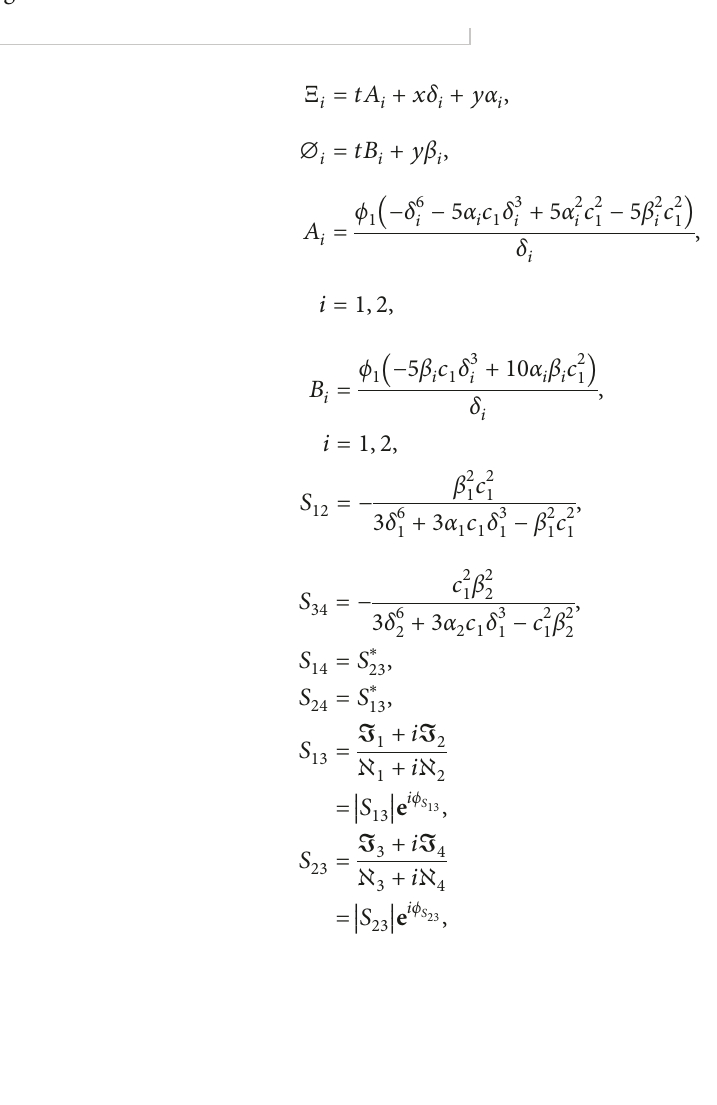
� 1 , c � 1/10 , t � − 2. (a) f 1. (b) f 2. (c) f 0 1